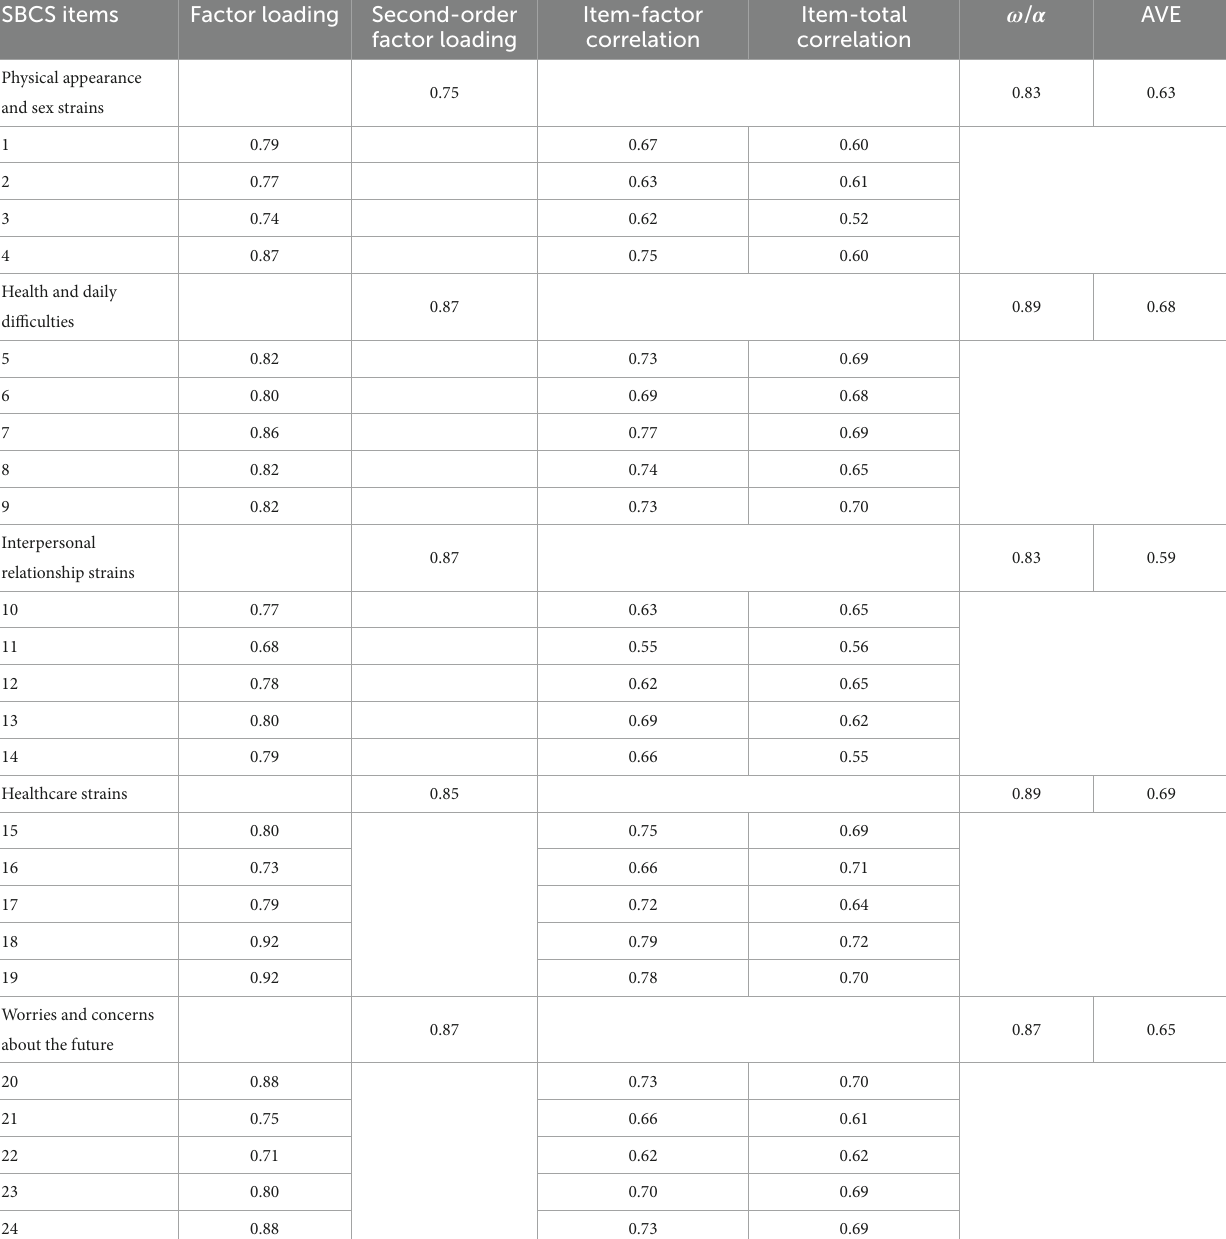
TABLE 6 Factor loadings, corrected item-factor and item-total correlations, McDonald’s omega and Cronbach’s alpha coefficients, and average variance extracted for factor scores ( N =